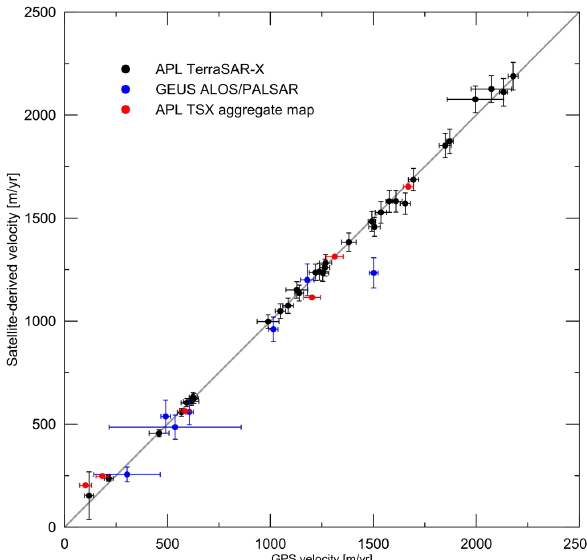
Figure 11. Comparison of satellite-derived velocities with GPS ve- locities. Horizontal error bars denote the standard deviation of the 7-day averaged GPS velocities in the period of the acquisition win- dow. The vertical error bars denote the formal error from the pro- cessing added to a 3% maximum error due to slope-dependent ef- fects. The black point with the lowest velocity (and largest vertical error bar) is SML-3, which originates from the ragged edge of a velocity map over Sermilik Bræ as discussed in the